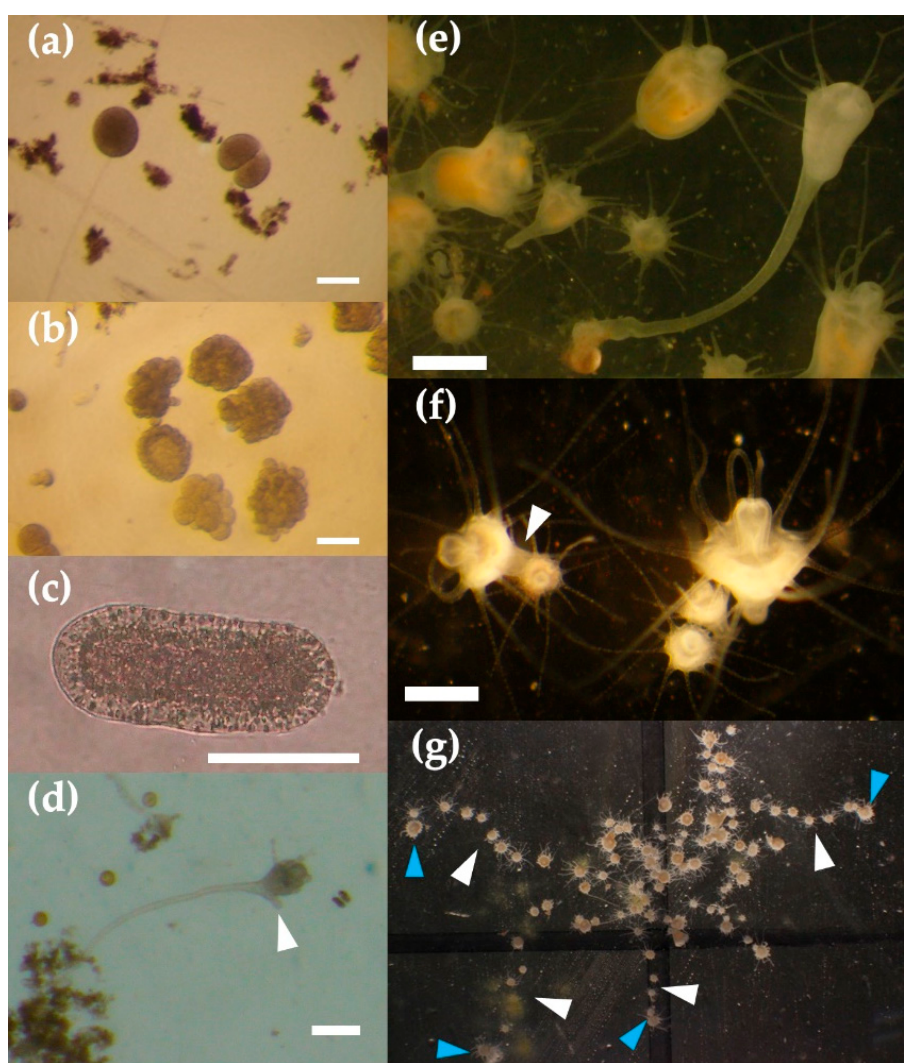
Figure 7. Life stages of Acromitus hardenbergi (egg to polyp). ( a ) Fertilized egg and two-cell embryo stage, scale bar = 100 µm; ( b ) multi-cell and blastocyst embryos stages, scale bar = 100 µm; ( c ) planula, scale bar = 100 µm; ( d ) primary polyp with short stolon just under calyx (white arrow), scale bar = 200 µm; ( e ) fully developed polyps and long-stalked tulip-type polyp (white arrow), scale bar = 500 µm; ( f ) asexual reproduction by budding (white arrow), scale bar = 500 µm; ( g ) clonal colony, where blue arrows show the mother polyps and white arrows show line of reproduced daughter polyps.